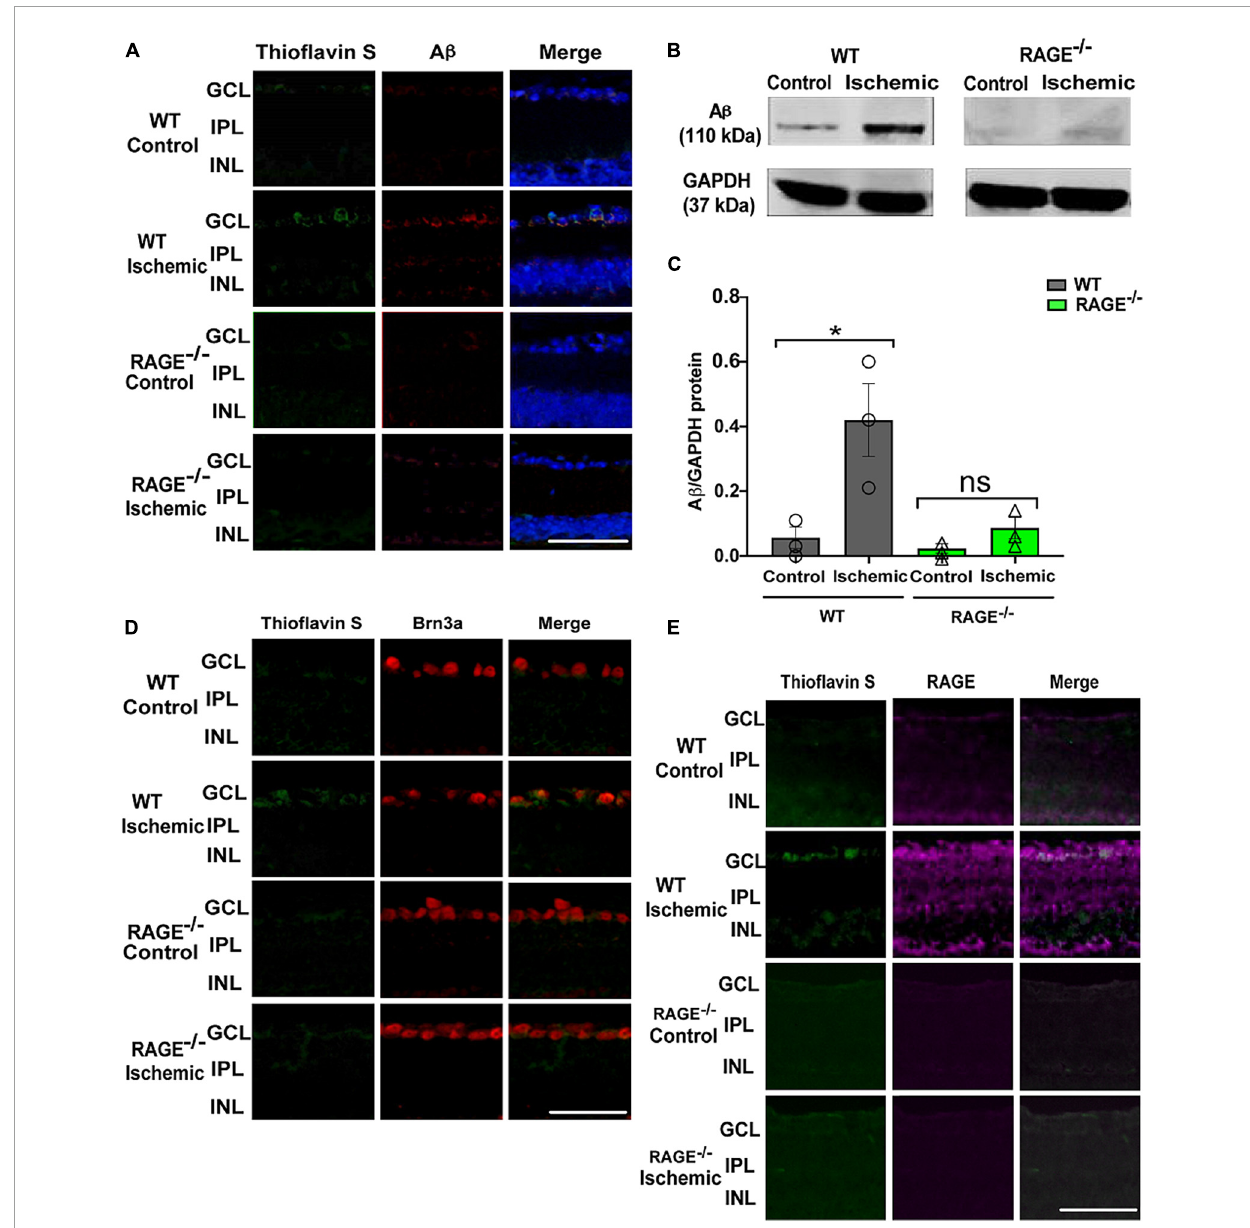
FIGURE2 Elevation of Aß deposition and RAGE upregulation in WT ischemic mice. (A) Immunostaining of WT and RAGE − / − retinas using Thioflavin S staining (green), Aß antibody (red), DAPI (blue) ( n = 3). Aß deposition was detected in GCL of WT ischemic mice. (B) Western blotting of Aß antibody in WT and RAGE − / − retinas shows the Aß band at 110 kDa. GAPDH was used as a control. (C) Densitometric analysis of Aß alteration after ischemia in WT and RAGE − / − . Data is presented as Aß/GAPDH fold change ( n = 3). (D) An increased labeling of Aß (green) and Brn3a (red) was detected in the GCL of WT ischemic mice ( n = 3). (E) Immunostaining of ischemic and control WT and RAGE − / − retinas using RAGE antibody (magenta). Increased labeling of Thioflavin S and RAGE in the GCL of ischemic WT mice is observed. * p = 0.04, ns: no significance, unpaired t -test. The scale bar is 50 µ